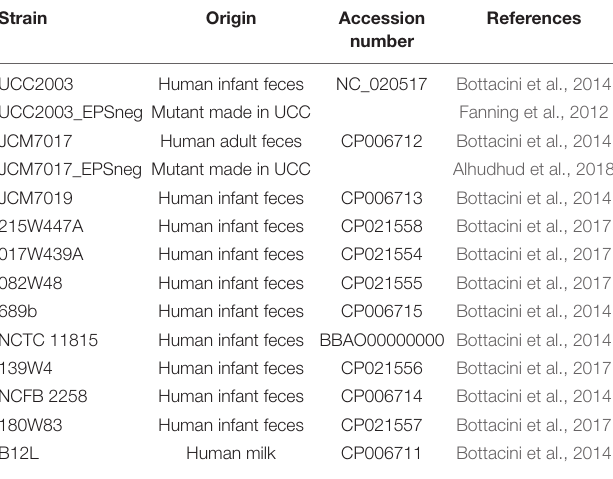
TABLE 1 | List of B. breve strains used in study, their origin of isolation and genome accession